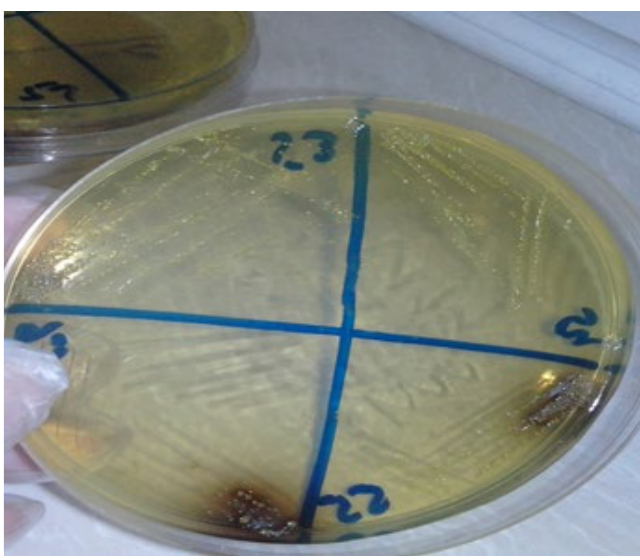
Fig. 7 Growth of bacteria on Oxford Listeria Specific Agar (Shows positive result) 5. Growth on blood agar: